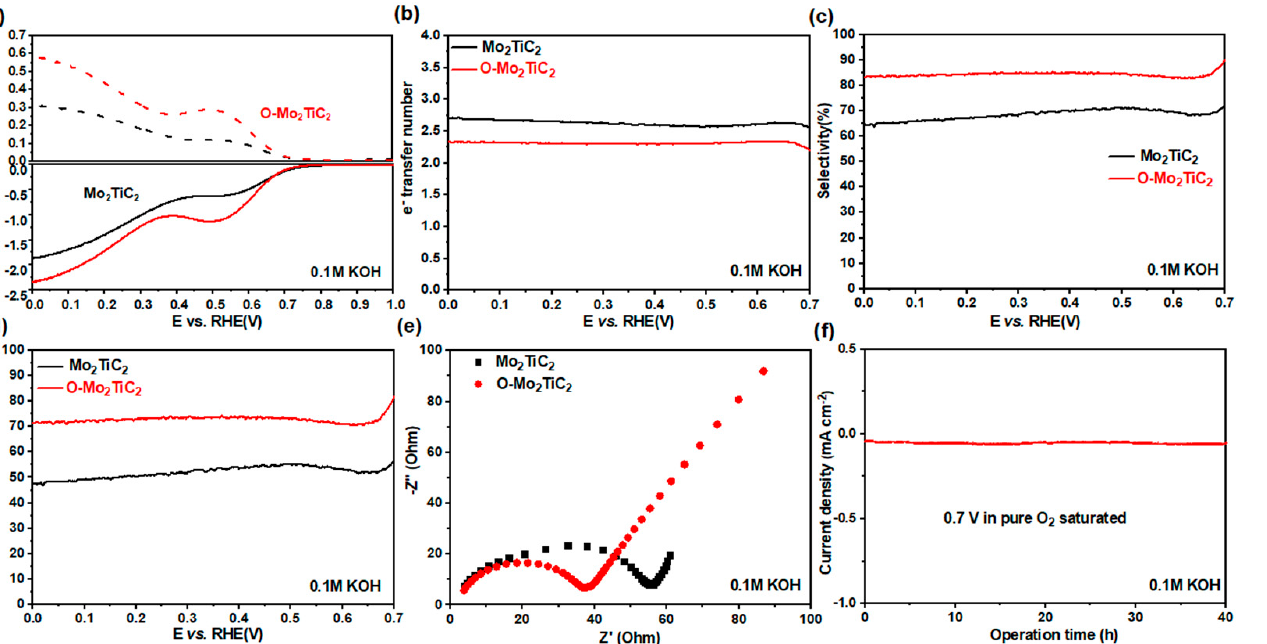
The electrocatalytic H 2 O 2 production activity of the as-prepared O-Mo 2 TiC 2 was evaluated by cyclic voltammetry (CV) in alkaline and neutral electrolytes, respectively, in Figure S3. Figure S3a shows almost no characteristic curve in the N 2 -saturated 0.1 M KOH solution, while a distinct reduction peak appears in the O 2 -saturated 0.1 M KOH solution (Figure S3b). Moreover, similar CV test results can also be observed in neutral solutions (Figure S3c,d), indicating that the O-Mo 2 TiC 2 has a remarkable electrocatalytic activity for oxygen reduction. Especially in 0.1 M KOH electrolyte, the reduction peak is very obvious, indicating that the ORR activity is significantly enhanced in an alkaline solution. Following the above results, we evaluated the electrocatalytic activity of the O-Mo 2 TiC 2 using an RRDE. Because the ORR can be divided into 4e − pathway and 2e − pathway, the electro- catalytic production of H 2 O 2 is a typical 2e − ORR pathway. To study the electrocatalytic H 2 O 2 production capability of O-Mo 2 TiC 2 under both alkaline and neutral conditions, we employed two electrolytes: 0.1 M KOH solution (pH~13) and 0.1 M Na 2 SO 4 solution (pH~7). Figures 5a and S4 show the electrochemical results of the catalysts in the two elec- trolytes (the rotation speed of the RRDE electrode at 1600 rpm), where the oxygen reduction current (solid line) was measured on the disk electrode, and the H 2 O 2 oxidation current (dotted line) were measured on platinum ring electrodes. According to Figures 5a and S4,